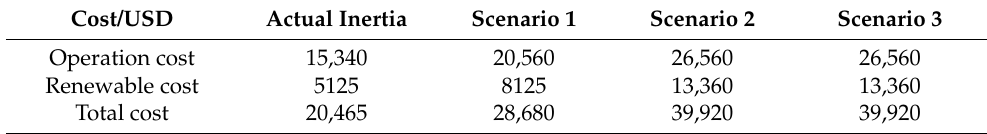
Table 3. Results for real-time scheduling